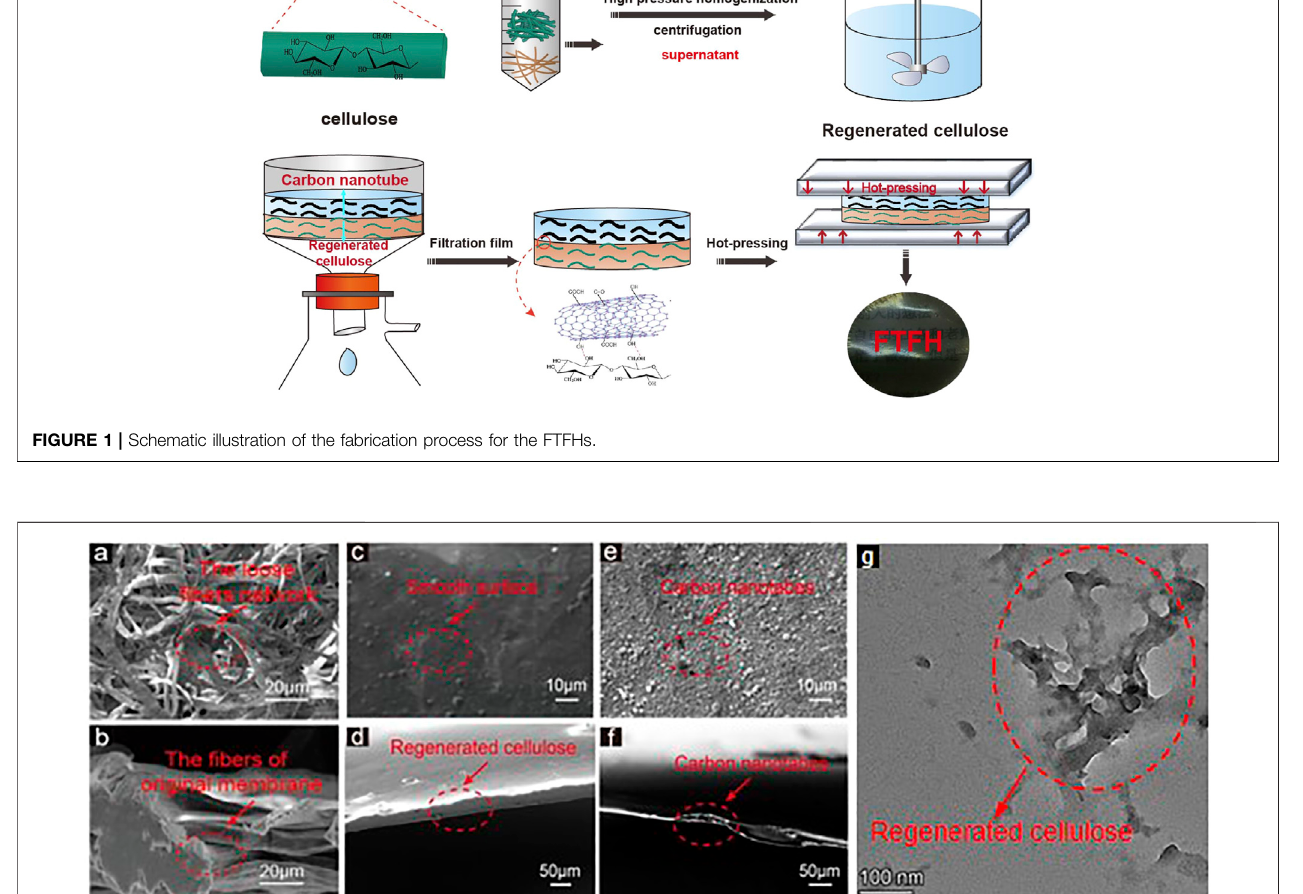
Frontiers in Energy Research |